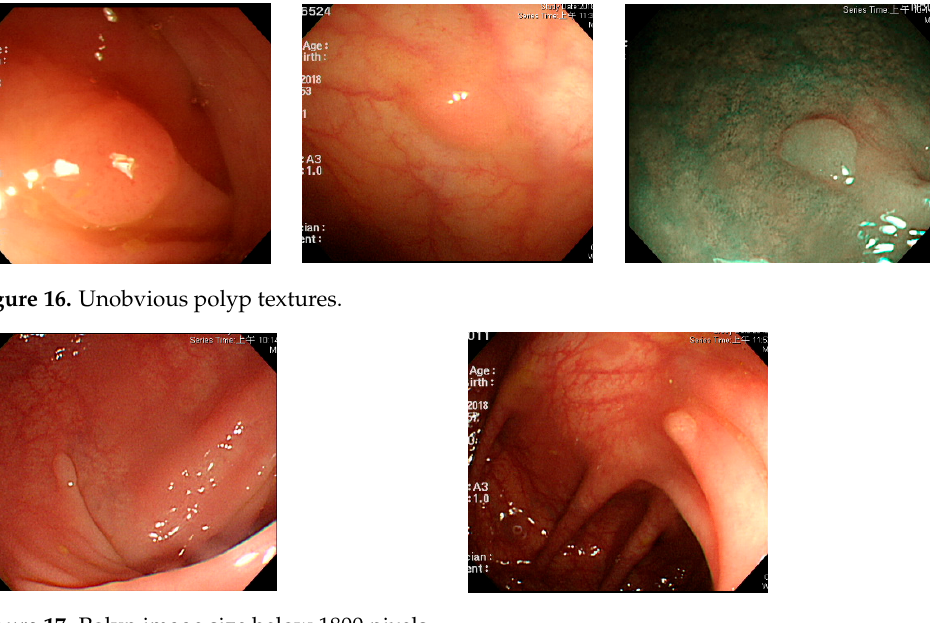
Figure 17. polyp image size below 1800 pixels. Figure 17. Polyp image size below 1800